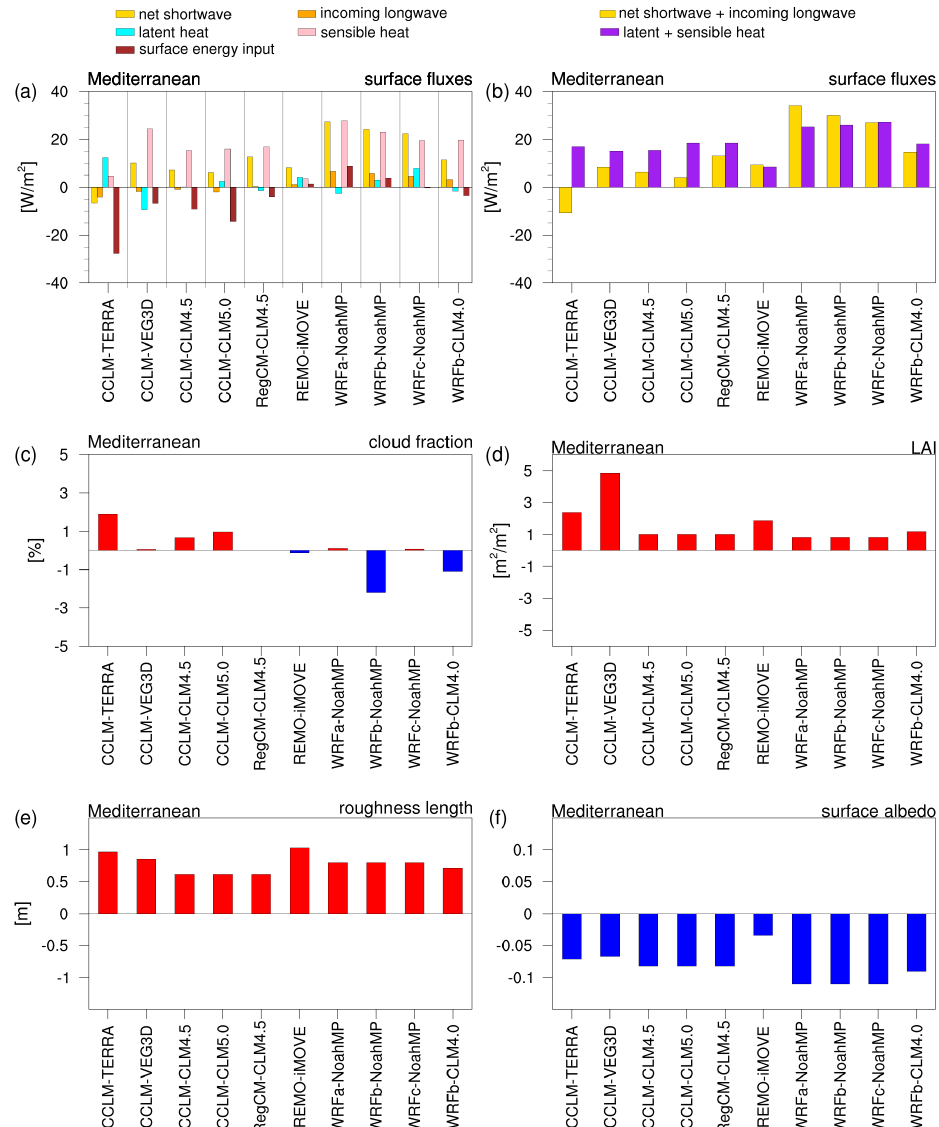
Figure 6. (a) Changes in surface energy balance components (FOREST minus GRASS) averaged over the Mediterranean in summer, (b) the changes in available radiative energy at the surface and in the sum of turbulent heat fluxes with afforestation (FOREST minus GRASS), (c) cloud fraction response to afforestation across models, (d) the inter-model differences in LAI, (e) surface roughness and (f) surface albedo in summer (yearly maximum). Positive (negative) values indicate an increase (decrease) with